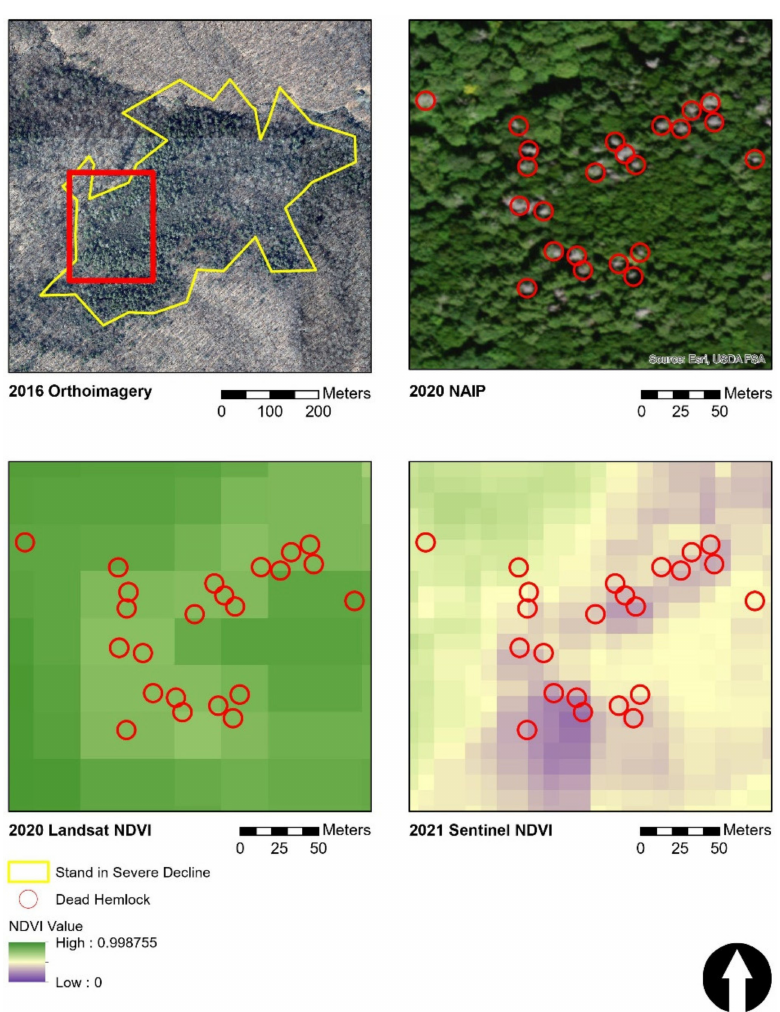
Figure 2. Imagery of a declining hemlock stand in the Catskill Mountains in New York. The leaf-off orthoimage ( top left ) highlights the spatial heterogeneity of the distribution of hemlocks (i.e., green conifers) throughout the stand ( top left ). The zoomed-in insets indicate the distribution of dead hemlock trees (red circles) within the stand using National Agriculture Imagery Program (NAIP) imagery ( top right ) and differences in the capacity of NDVI from 30 m Landsat imagery ( bottom left ) and 10 m Sentinel-2 imagery to detect forest